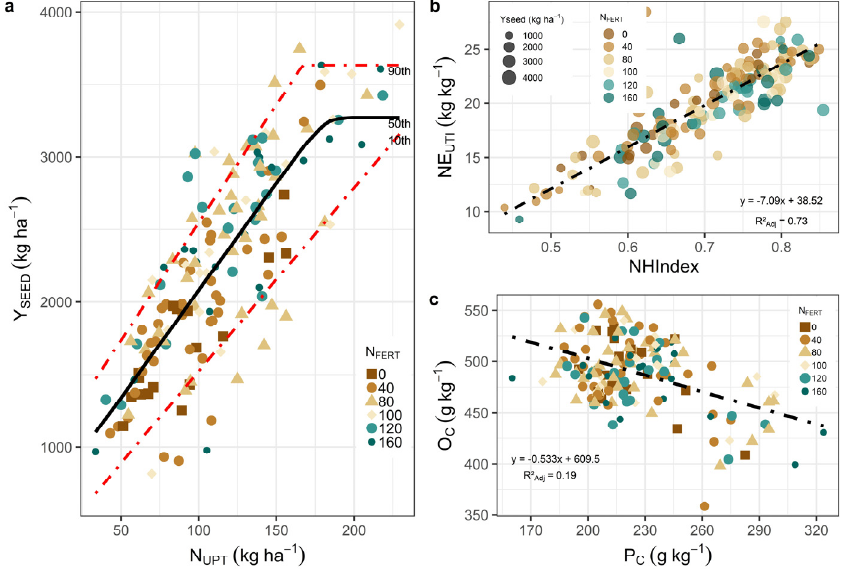
Figure 4. Quantile regression models fitted to different percentiles relating N UPT (kg ha − 1 ) to Y SEED (kg ha − 1 ) ( a ), relationship between NHI and NE UTI ( b ), and relationship between PC and OC ( c ). (*** p -values < 0.001). Each data point is a plot on a farm with fertilization treatment.